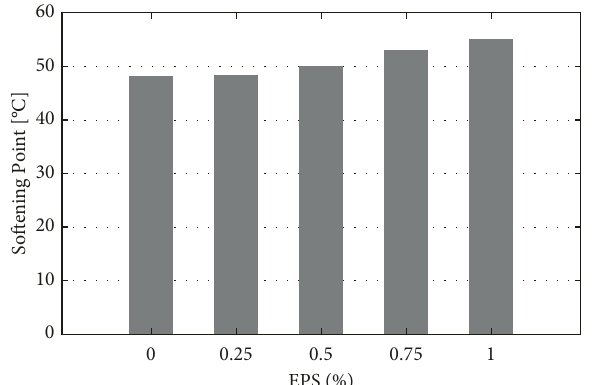
Figure 7: Variation of ductility value.